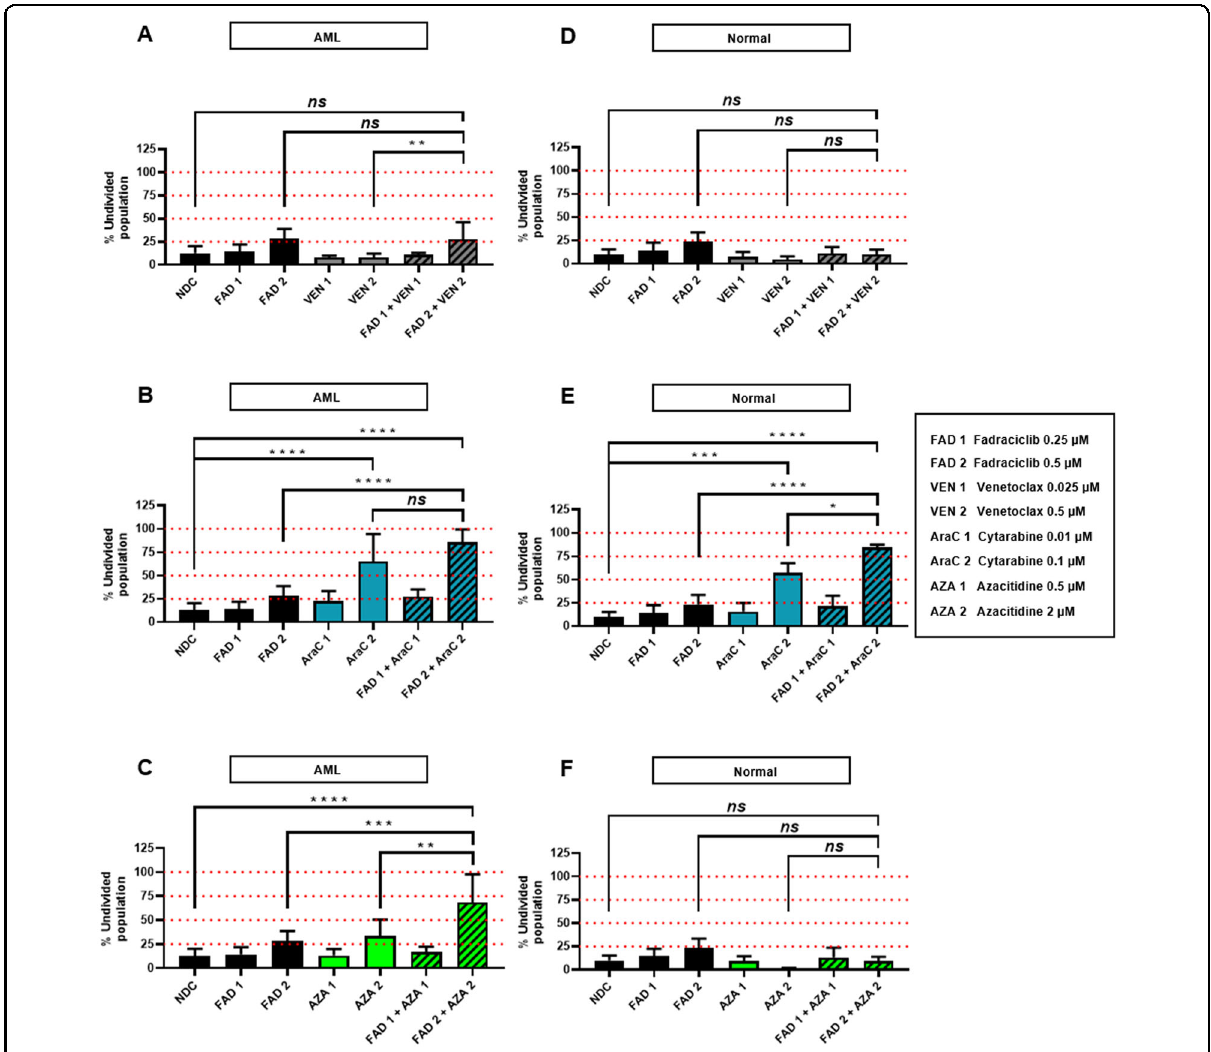
Fig. 4 A therapeutic window was observed in cell proliferation assays with the combination of fadraciclib and AZA. A Summary bar charts of fl ow cytometry data of the percentage of undivided populations of primary AML and D normal hematopoietic patient samples treated with fadraciclib and/or VEN for 72 h. n = 6/3. B Summary bar charts of fl ow cytometry data of the percentage of undivided populations of primary AML and E normal hematopoietic patient samples treated with fadraciclib and/or AraC for 72 h. n = 6/3. C Summary bar charts of fl ow cytometry data of the percentage of undivided populations of primary AML and F normal hematopoietic patient samples treated with fadraciclib and/or AZA for 72 h. n = 6/3. Graphs depict mean ± SD (* p < 0.05, ** p < 0.01, *** p < 0.001, **** p < 0.0001). Data were compared using